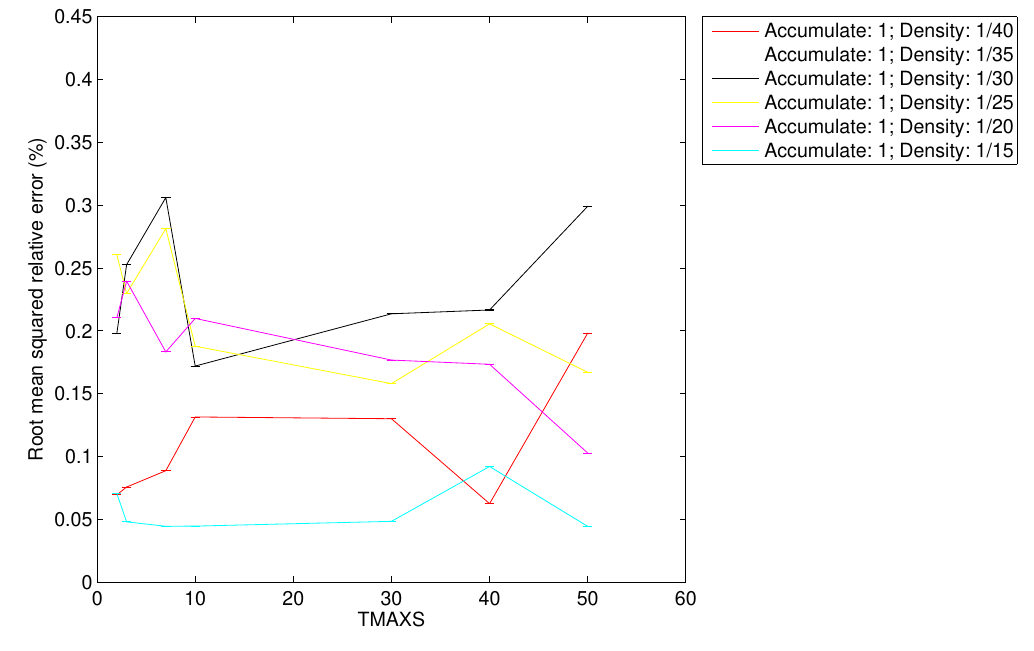
Figure 18. RMS relative error for